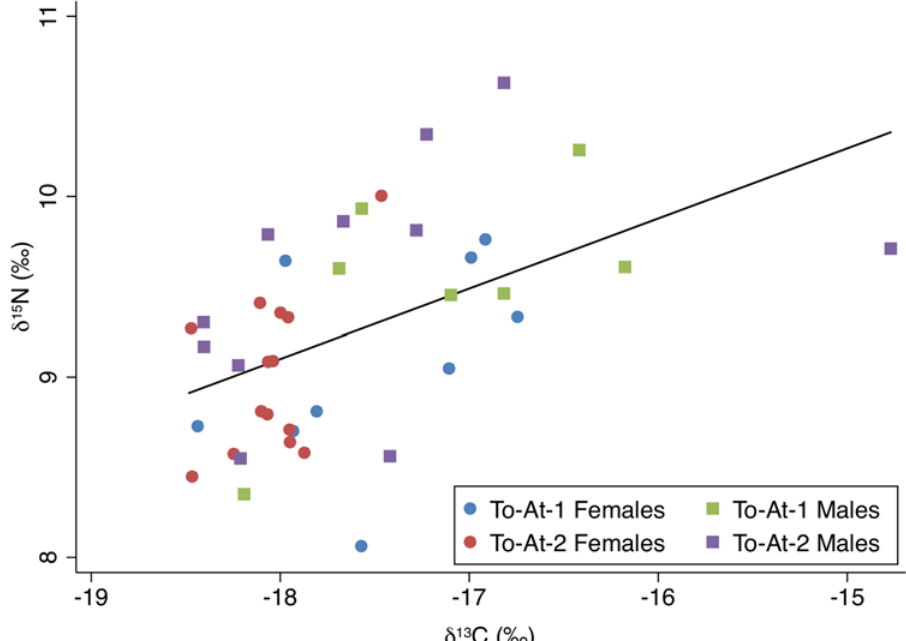
Fig 3. δ 13 C and δ 15 N values plotted by sex and burial mound with fitted regression line (y = 0.40x + 16.3, p < 0.001).